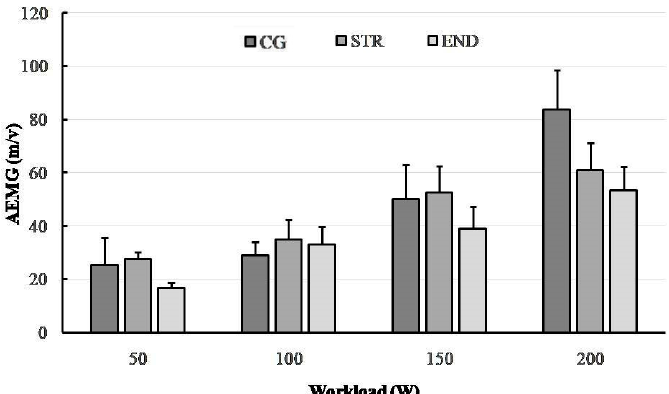
Figure 2. The changes in mean power frequency (MPF) in the research groups(END—triathlon; STR—bodybuilder; CG—recreationally active) during progressive cycling exercise test at subsequent workloads; point and whiskers—mean ± SD.